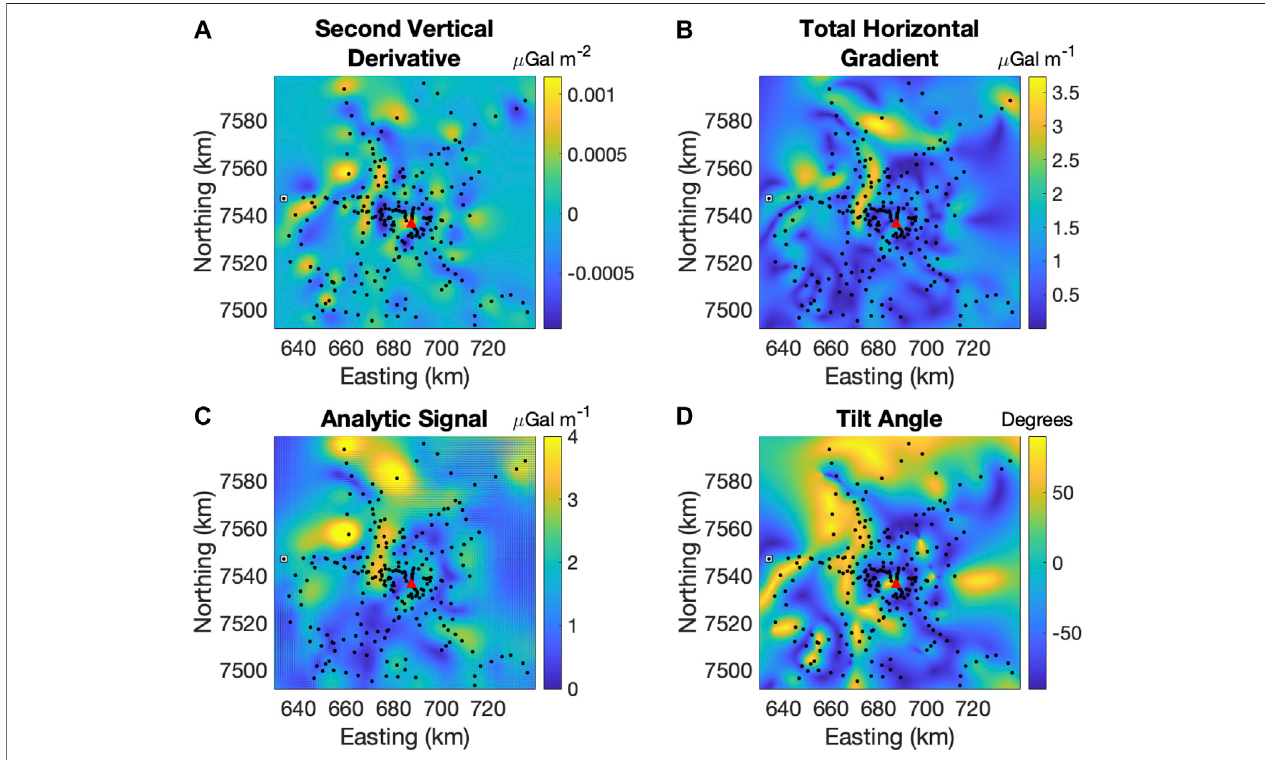
FIGURE 4 | Derivative analysis maps of the gravity fi eld at Uturuncu. The red triangle marks the location of Uturuncu, the black dots are gravity measurement locations. (A) Second vertical derivative (LaFehr and Nabighian, 2012) (B) Total horizontal gradient (Cordell, 1979) (C) Analytic signal (Nabighian, 1972) (D) Tilt angle (Miller and Singh,